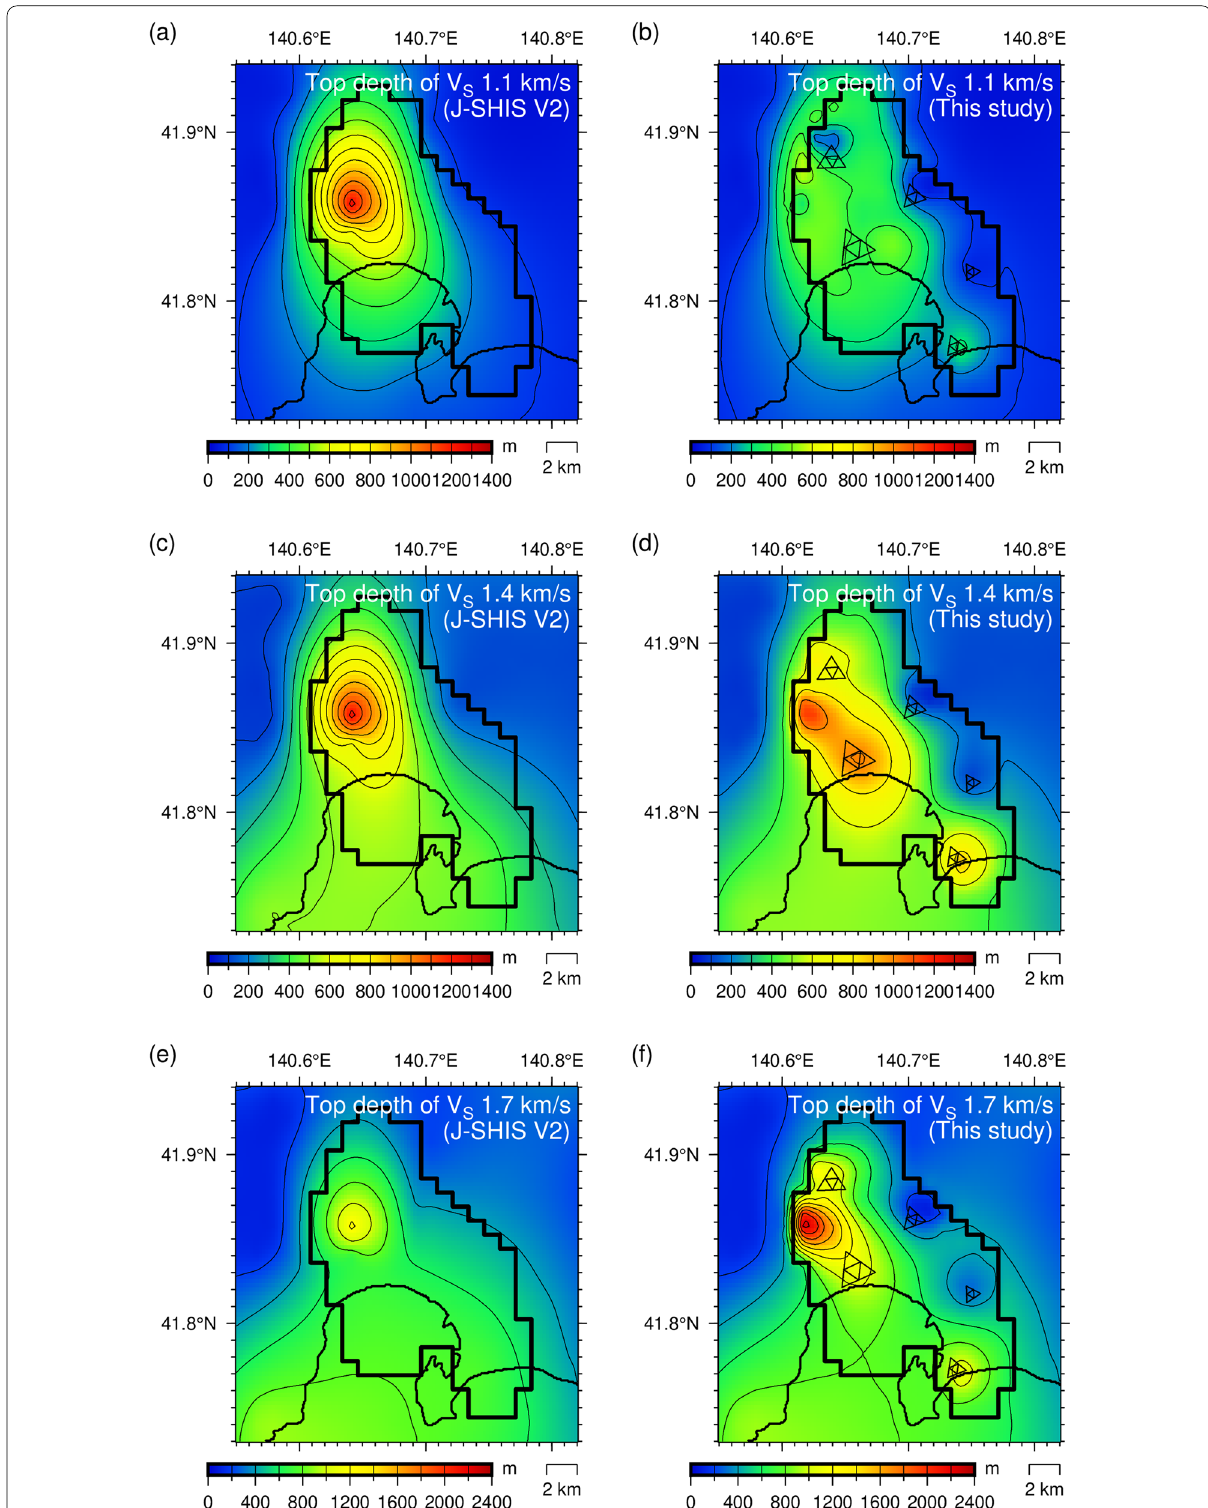
Fig. 6 Depth distributions of the top surface of each velocity layer. a V S of J-SHIS V2 model, d V S 1.4 km/s of this study, e V S = target area of the velocity structure modeling. The triangles indicate the microtremor array survey